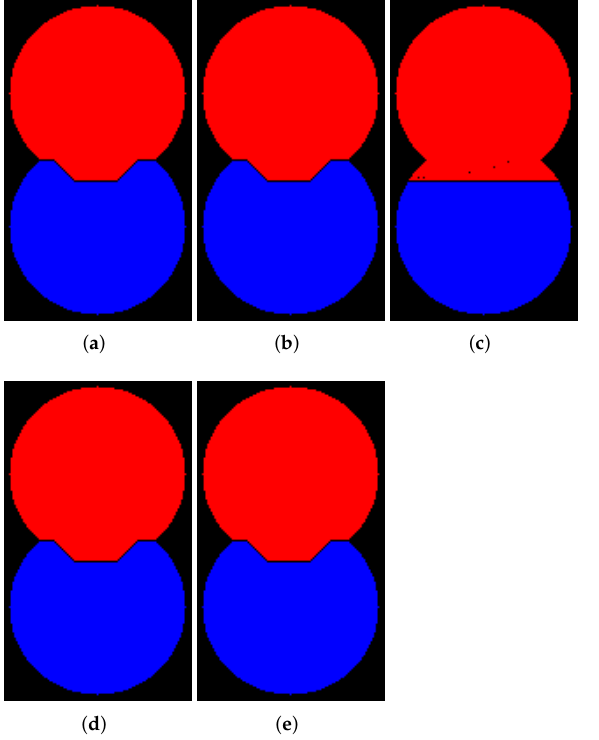
Figure 9. Results of segmentation via watershed with WL (4-connectivity): ( a ) ImageJ; ( b ) ITK; ( c ) Mahotas; ( d ) Scikit-image; ( e )